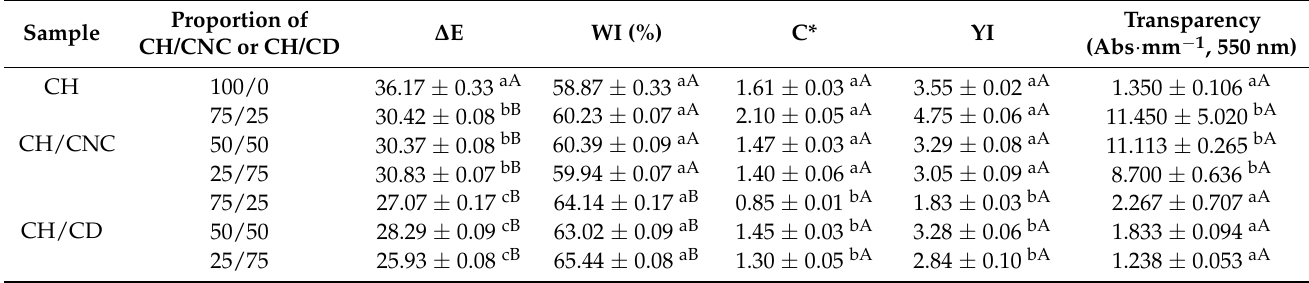
Table 3. Optical properties of CH, CH/CNC and CH/CD final formed edible